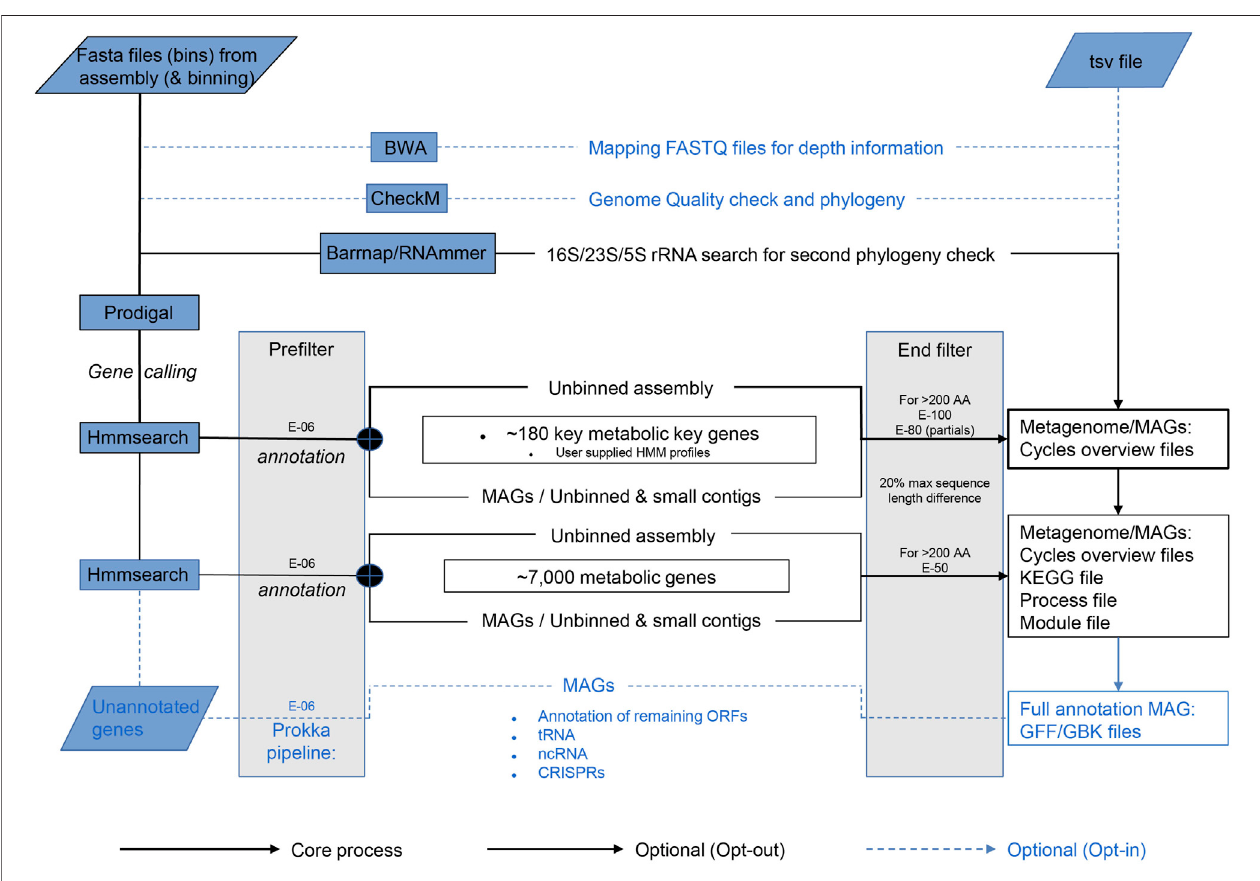
FIGURE 1 | Schematic overview of the Metascan pipeline. The bold black lines represent the core analyses of the program. The thin black lines show the default Metascan pipeline when no options are opted out. The blue dotted lines indicate the options that can be invoked through the command line for full annotations.